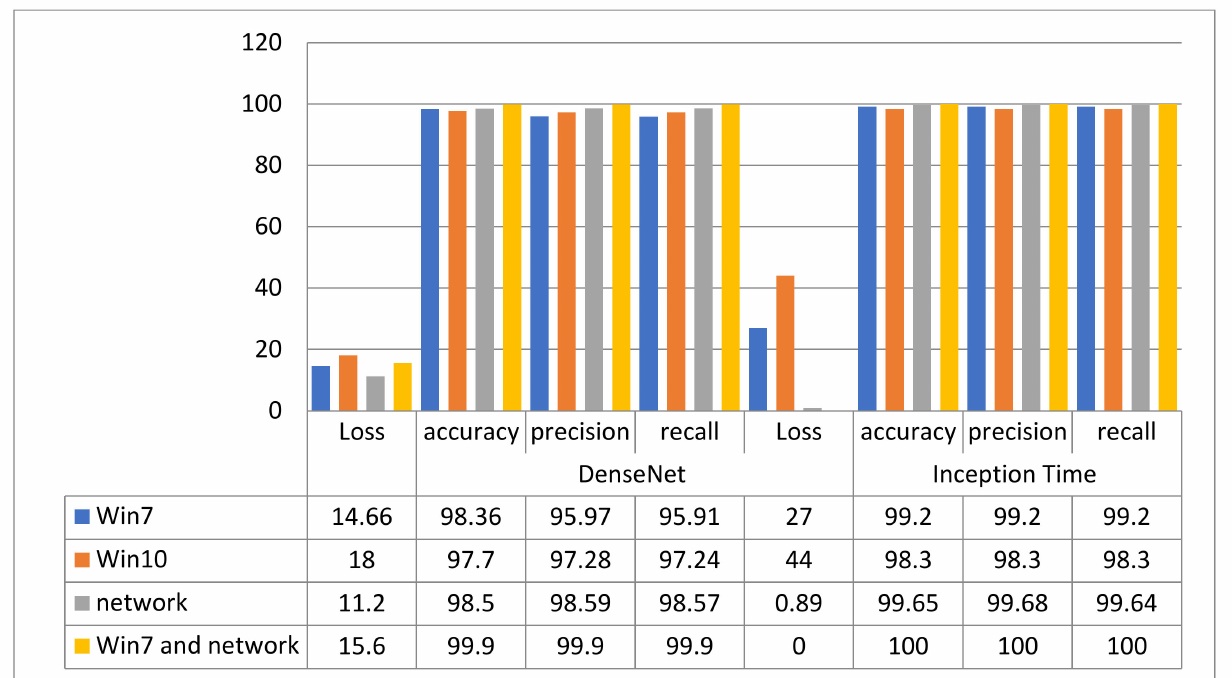
Figure 10. The comparison of results between DenseNet and Inception Time using the ToN-IoT dataset.